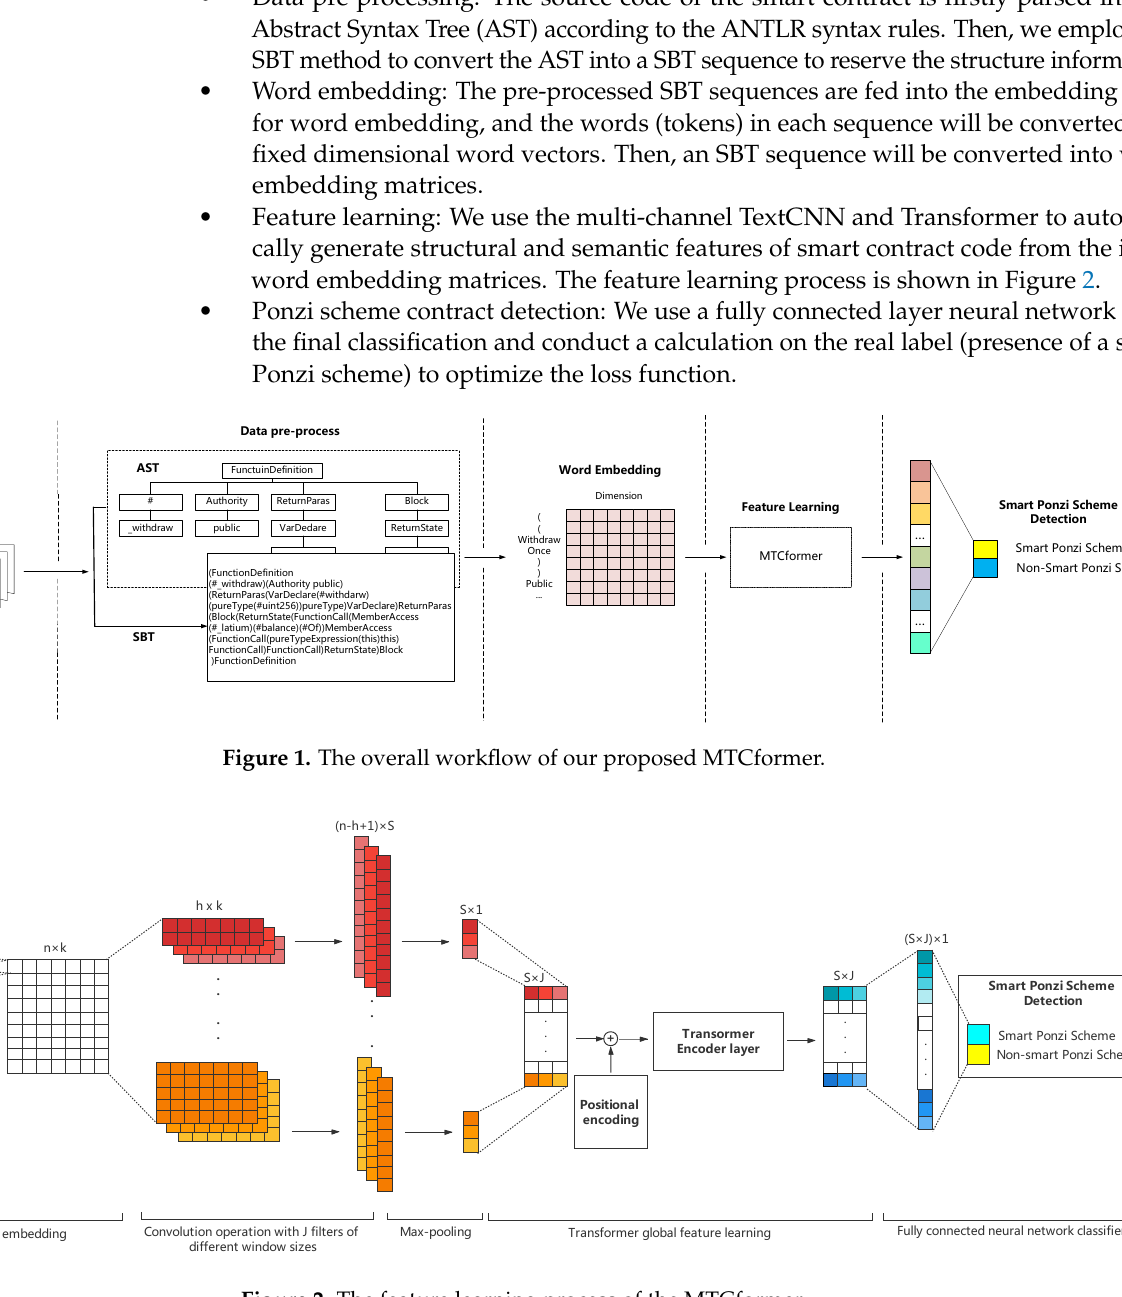
Figure 2. The feature learning process of the